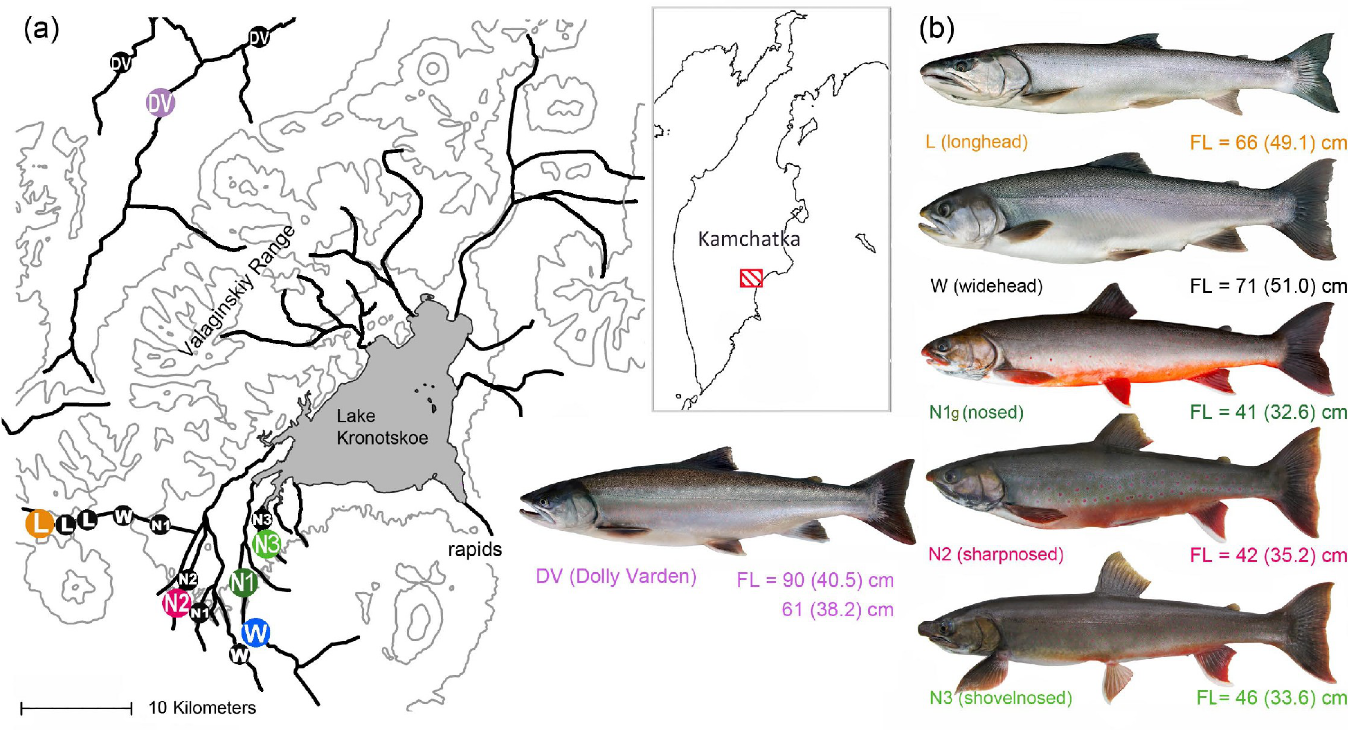
Fig 1. The area under investigation and the location of the reproduction sites, where the temperature dynamics was analyzed ( a ; positions of the spawning grounds for fish sampling are put in colour); the adult fish external appearance ( b ; maximal (mean) fork length is shown for the morphs, Dolly Varden’s fork length–for the river where the spawners were caught (Kamchatka River, above), and for the Kronotskaya River population (below)).